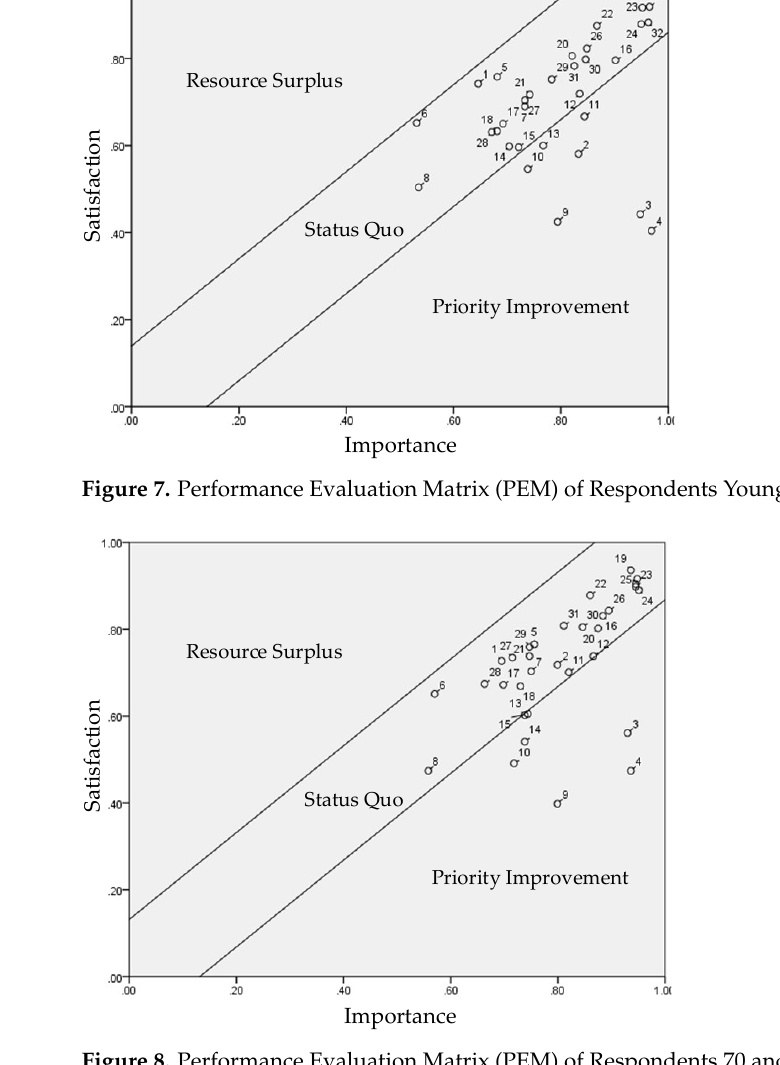
Figure 8. Performance Evaluation Matrix (PEM) of Respondents 70 and Older.